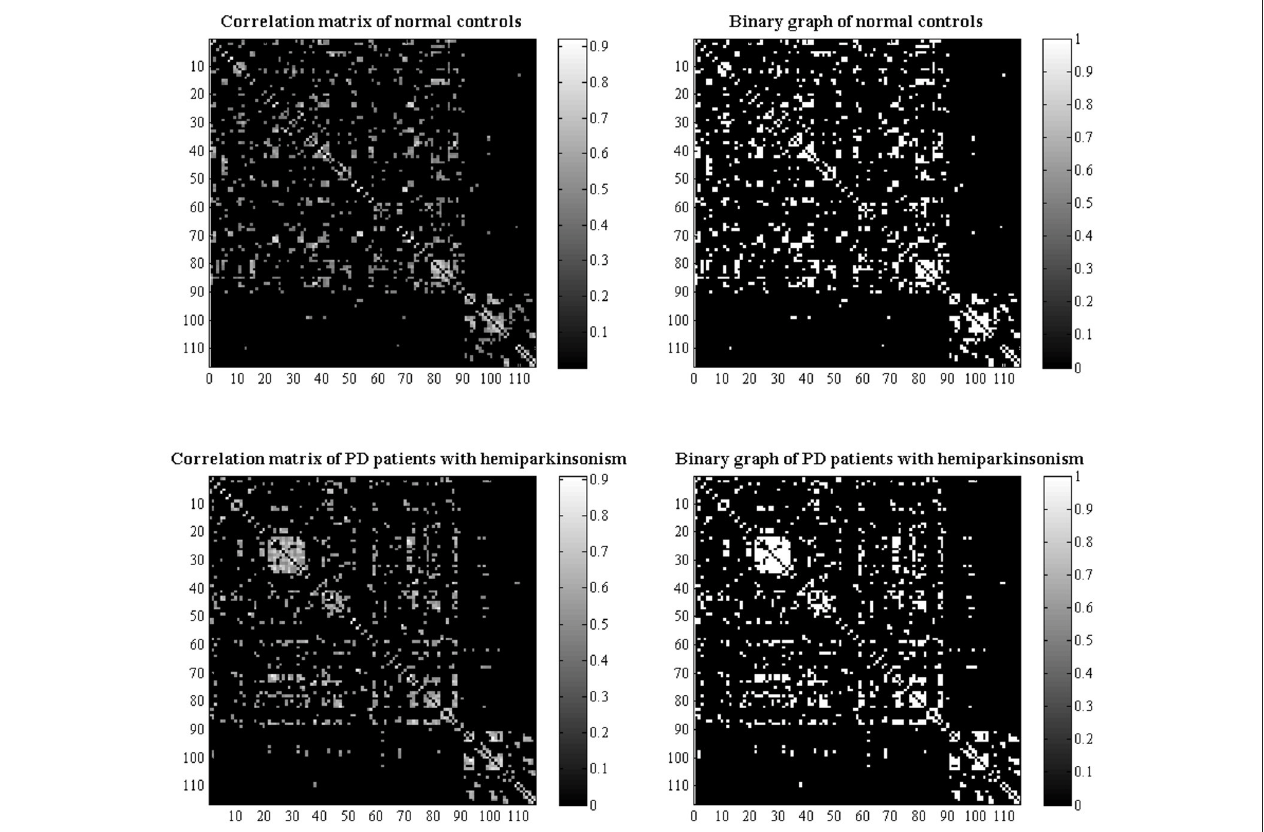
FIGURE 1 | Structural correlation matrices with 116 × 116 in normal controls and PD patients with hemiparkinsonism were acquired. The left column showed the weighted correlation matrices while the right column showed the corresponding binary correlation matrices. Based on the weighted correlation matrices, we used a range of densities from 0.1 to 0.5 with an interval of 0.02 to construct network graphs